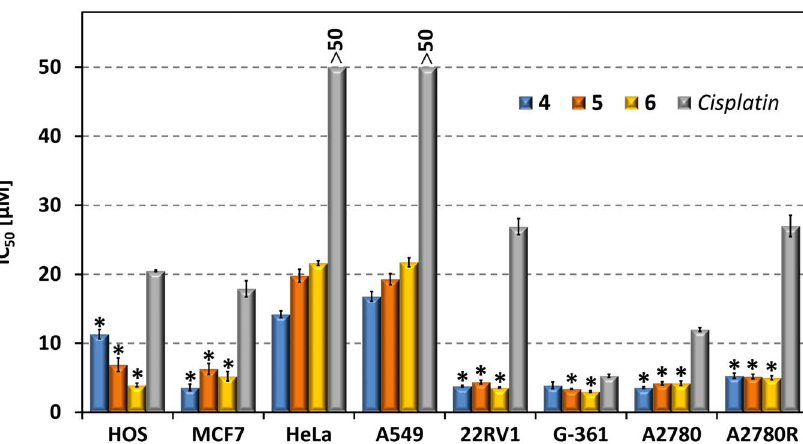
Figure 5. The results of invitro cytotoxicity against selected cancer cell lines for complexes 4–6 and cisplatin . The cells were exposed to the employed complexes for 24 h. Measurements were performed in triplicate and each cytotoxicity experiment was repeated three times. The given IC 50 6 SE ( m M) values represent an arithmetic mean. The asterisk (*) denotes significant difference (ANOVA, p , 0.05) between 4 – 6 and cisplatin .